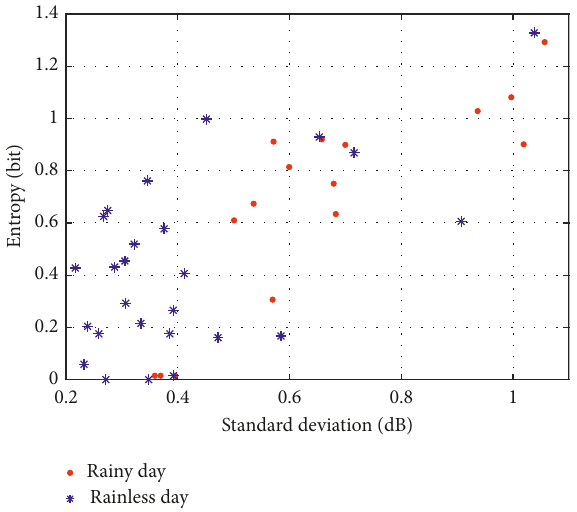
Figure 3: Standard deviation and information entropy distribution of rainy and rainless days from 1st November to 3rd December.